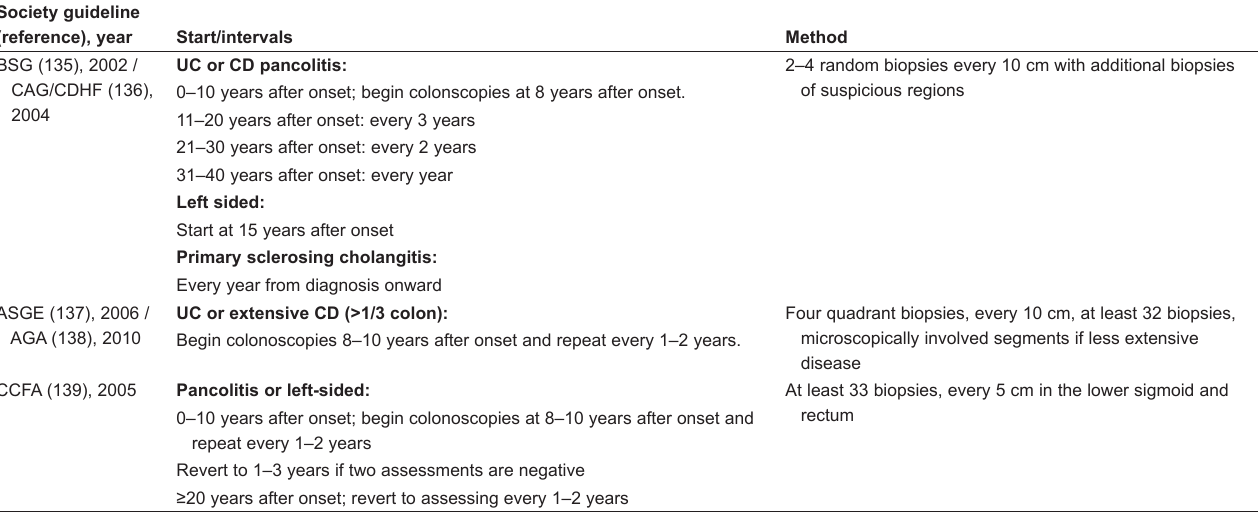
TAble 3 Summary of guidelines for surveillance of dysplasia in patients with long-standing ulcerative or Crohn’s colitis Society